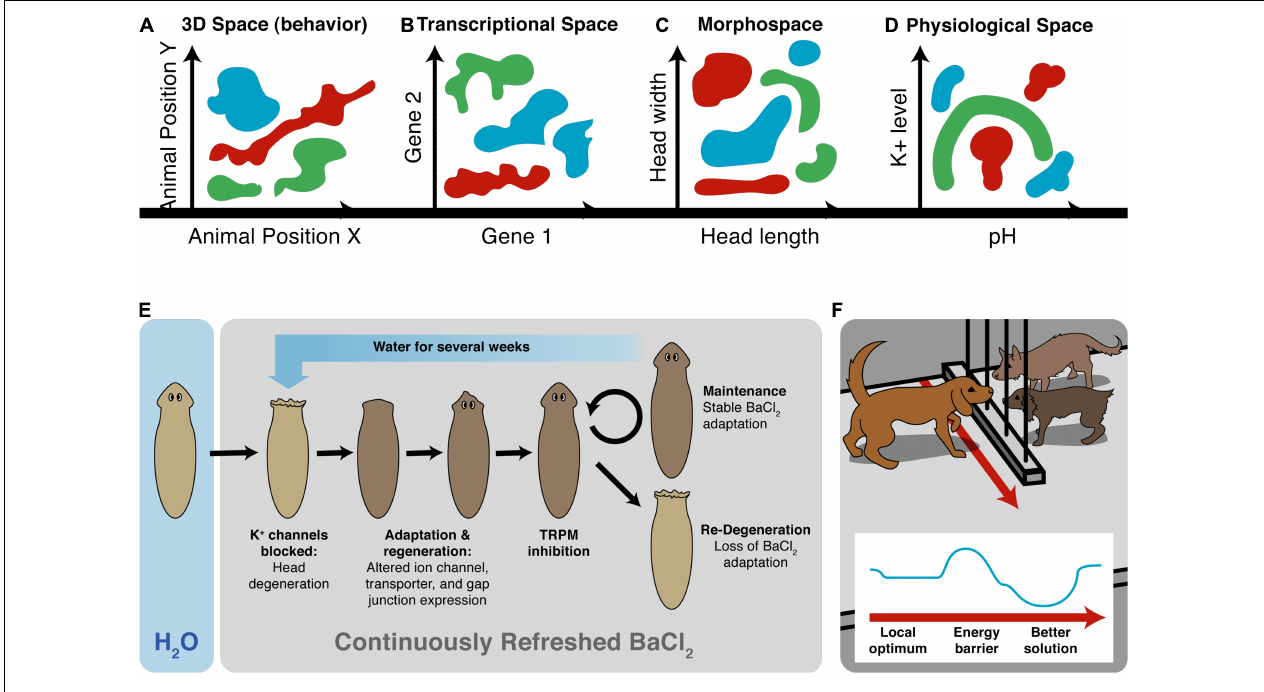
FIGURE 5 | Cognitive agents solve problems in diverse spaces. Intelligence is fundamentally about problem-solving, but this takes place not only in familiar 3D space as “behavior” (control of muscle effectors for movement) (A) , but also in other spaces in which cognitive systems try to navigate, in order to reach better regions. This includes the transcriptional space of gene expression (B) here schematized for two genes, anatomical morphospace (C) here schematized for two traits, and physiological space (D) here schematized for two parameters. An example (E) of problem-solving is planaria, which placed in barium (causing their heads to explode due to general blockade of potassium channels) regenerate new heads that are barium-insensitive (Emmons-Bell et al., 2019). They solve this entirely novel (not primed by evolutionary experience with barium) stressor by a very efficient traversal in transcriptional space to rapidly up/down regulate a very small number of genes that allows them to conduct their physiology despite the essential K + flux blockade. (F) The degree of intelligence of a system can be estimated by how effectively they navigate to optimal regions without being caught in a local maximum, illustrated as a dog which could achieve its goal on the other side of the fence, but this would require going around—temporarily getting further from its goal (a measurable degree of patience or foresight of any system in navigating its space, which can be visualized as a sort of energy barrier in the space, inset). Images by Jeremy Guay of Peregrine